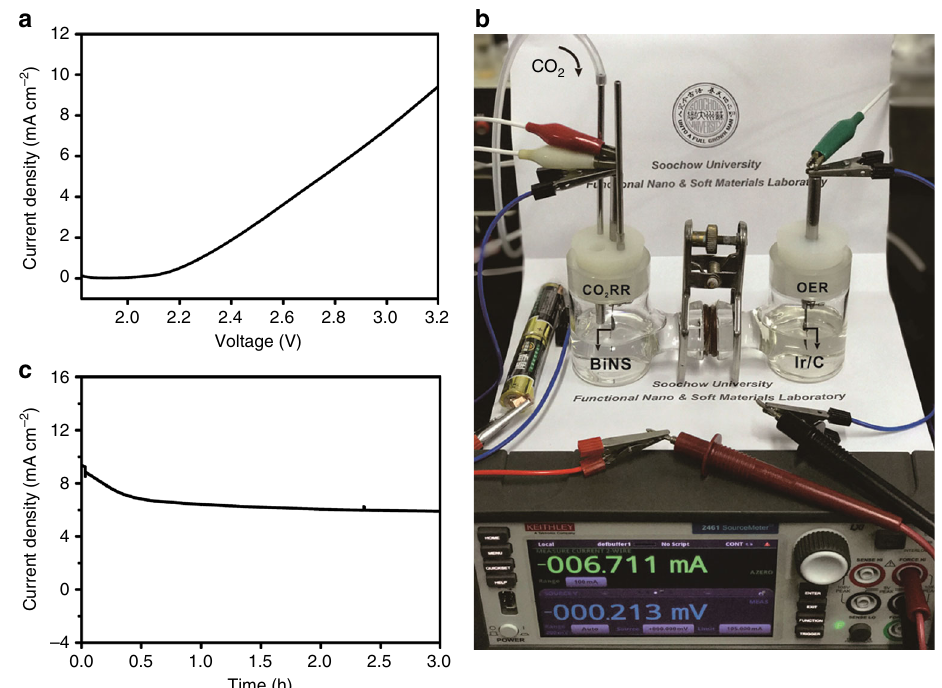
Fig. 5 Full-cell electrolysis by coupling BiNS CO 2 RR with Ir/C OER. a Polarization curve for the full cell CO 2 RR-OER electrolysis; b photograph of the setup for the CO 2 RR-OER electrolysis powered by two AA-size alkaline batteries; c current evolution for the battery-powered CO 2 RR-OER